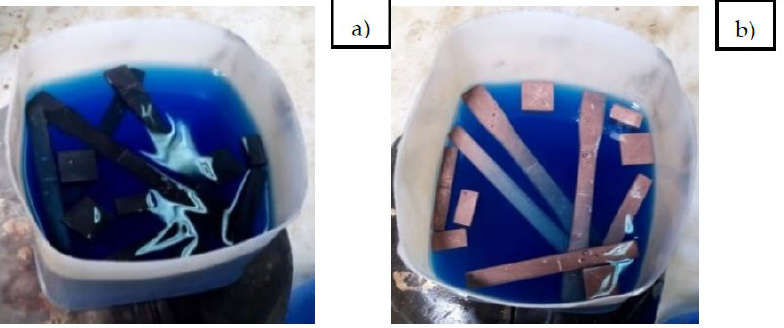
Figure 3. ( a ) PETG+MWCNT specimen activation stage; ( b ) copper deposition on the PETG+MWCNT specimens.